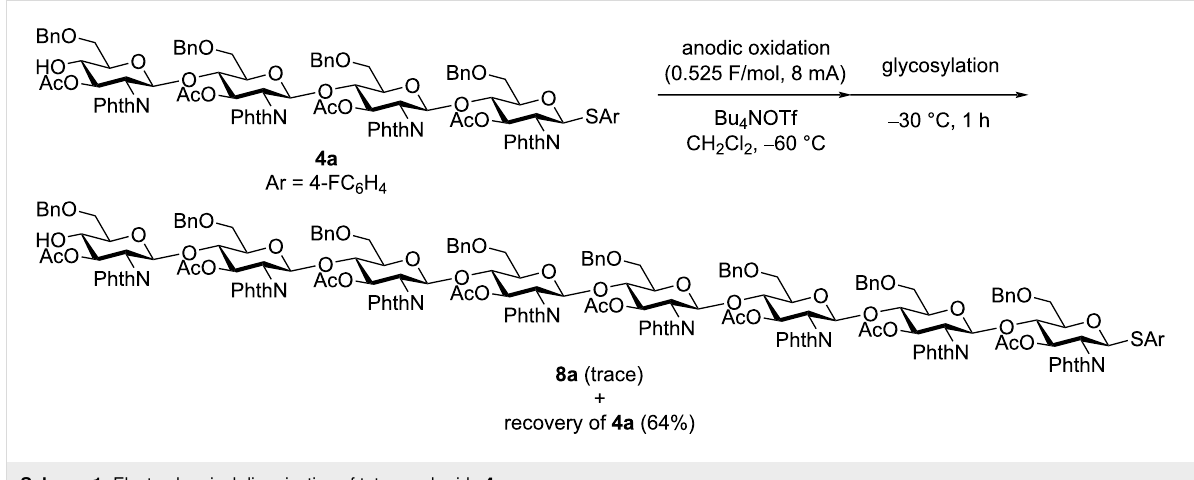
Scheme 1: Electrochemical dimerization of tetrasaccharide 4a .